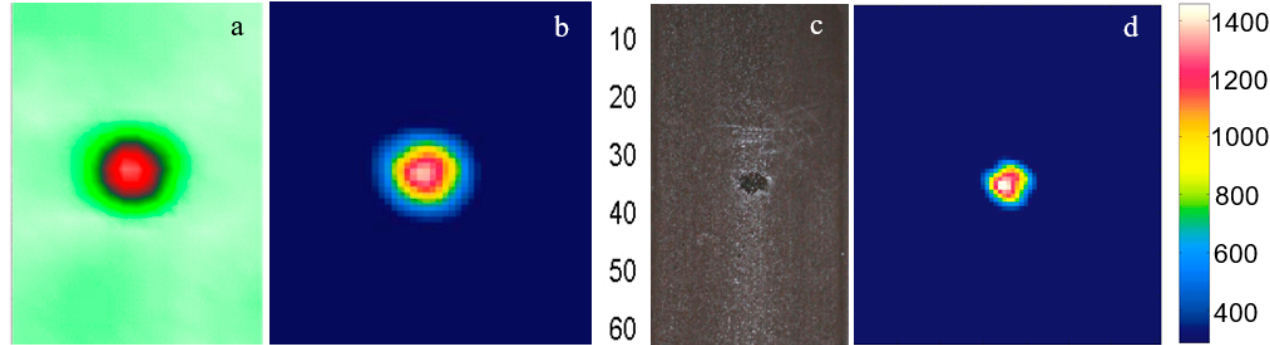
Figure 12. Resonant HH AE images:obtained with laser vibrometry ( a ); circular FBH in PMMA ( b ); point impact in CFRP (~5 × 5 mm 2 ) ( c ); point impact in CFRP ( d ).